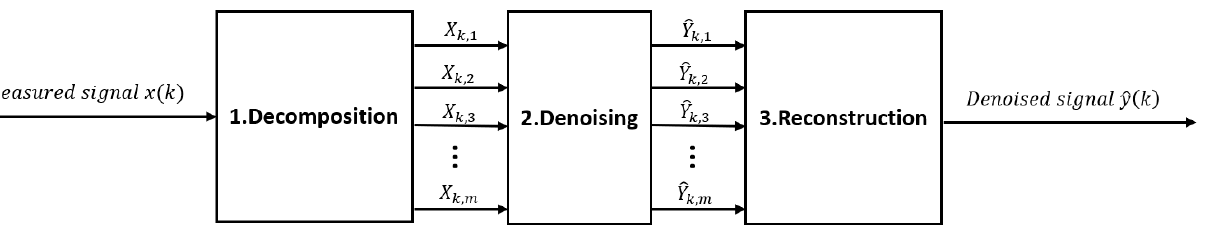
Figure 7. Block diagram of the decomposition